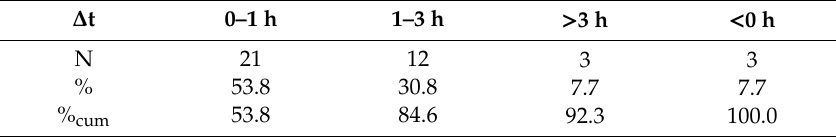
16 of 29 Figure 8. Spatial distribution of instability processes (coloured stars) occurred in the alpine and pre- alpine provinces in the Lombardy Region in the period 1927–2008, for which time of failure was